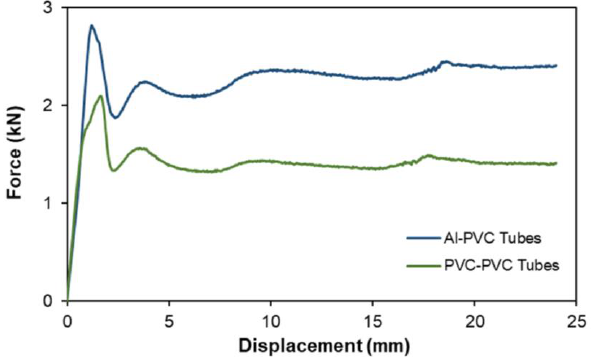
Figure 6. Experimental force – displacement evolution for the inner tube reduction of PVC – PVC and aluminum – PVC combinations up to a penetration depth 𝑑 𝑝 of 24